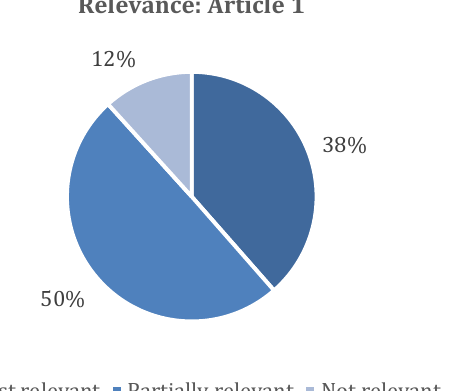
Figure 1: Relevance of responses to Articles 1 and 2